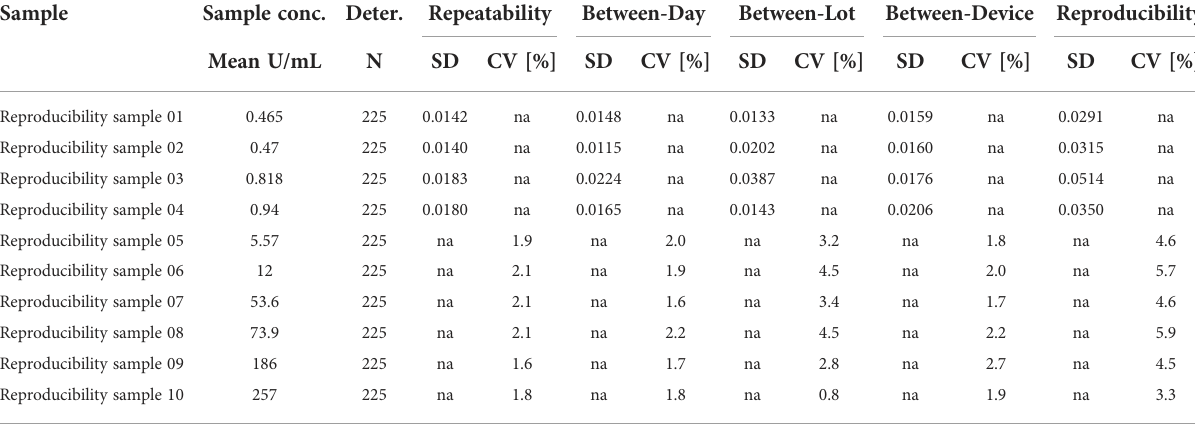
TABLE 4 Reproducibility of the ACOV2S assay.